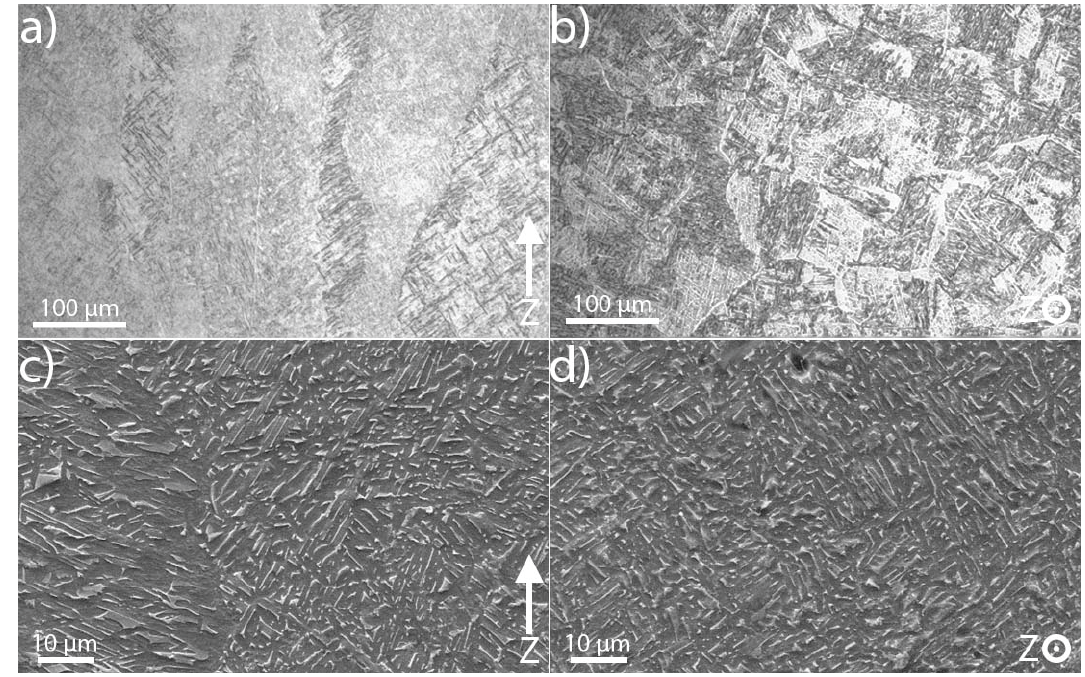
Figure 2. Light optical microscopy image of S7V ( a ), and S7H ( b ). In ( c ) and ( d ), the images are taken with a SEM where the specimens used are S8V and S8H respectively. Z indicates the build direction and etching procedure employed to obtain the alloy microstructures was by immersion in Kroll’s etchant for 10 s.